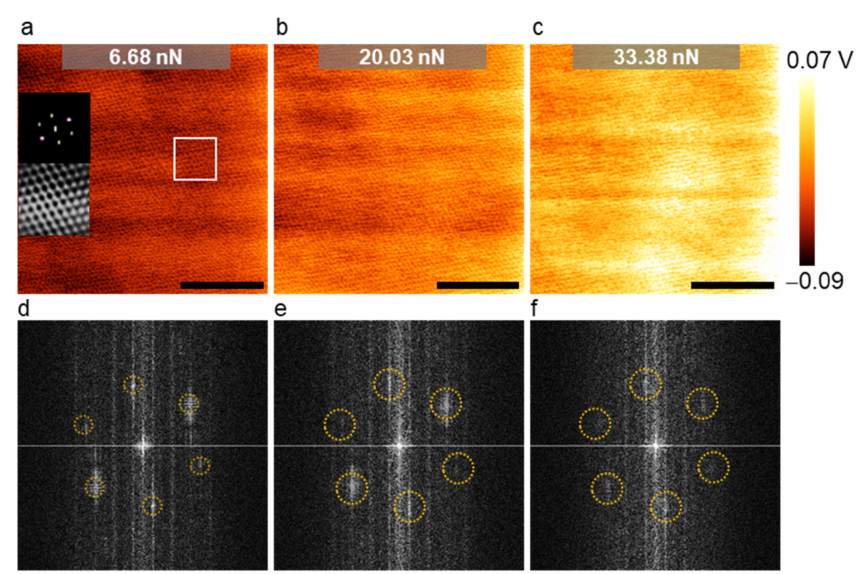
Figure 6. The effect of the load (i.e., setpoint) on LFM lattice images. ( a – c ) LFM raw data of MoS 2 at various loads (calibrated scale bar: 5 nm; frequency: 17.1 Hz). The insets in ( a ) represent the filtered FFT images of the area enclosed by the white rectangle and its corresponding inverse FFT image; ( d – f ) corresponding unfiltered FFT images of MoS 2 . The six FFT spots associated with the hexagonal lattice structure are highlighted with dotted circles. The spots were less noticeable at a load of 33.38 nN, as seen in ( f